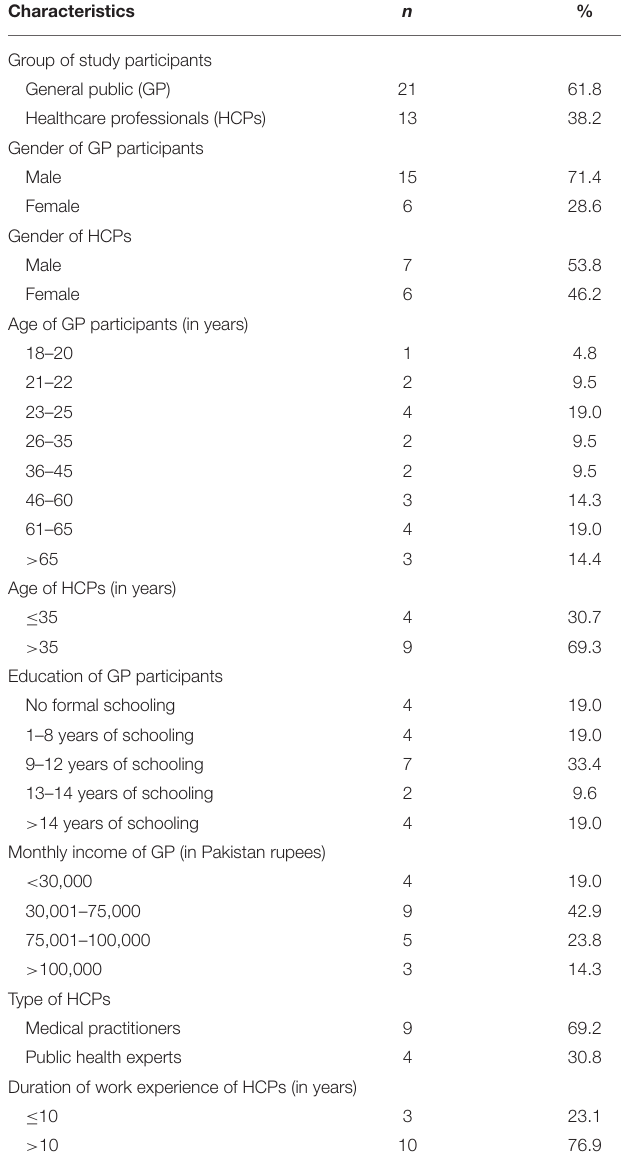
TABLE 1 | Socio-demographic characteristics of the study participants ( n =